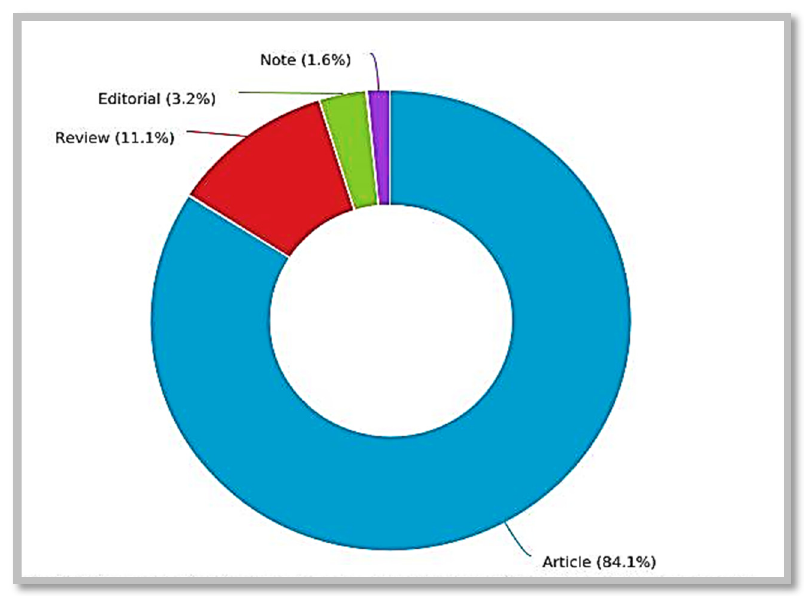
Figure 4. Types of Documents Retrieved.